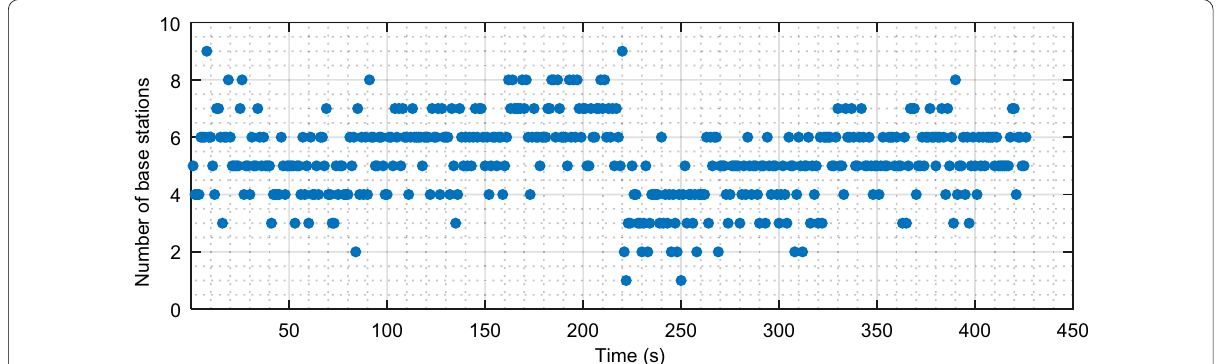
Fig. 13 Number of observable base stations in a good